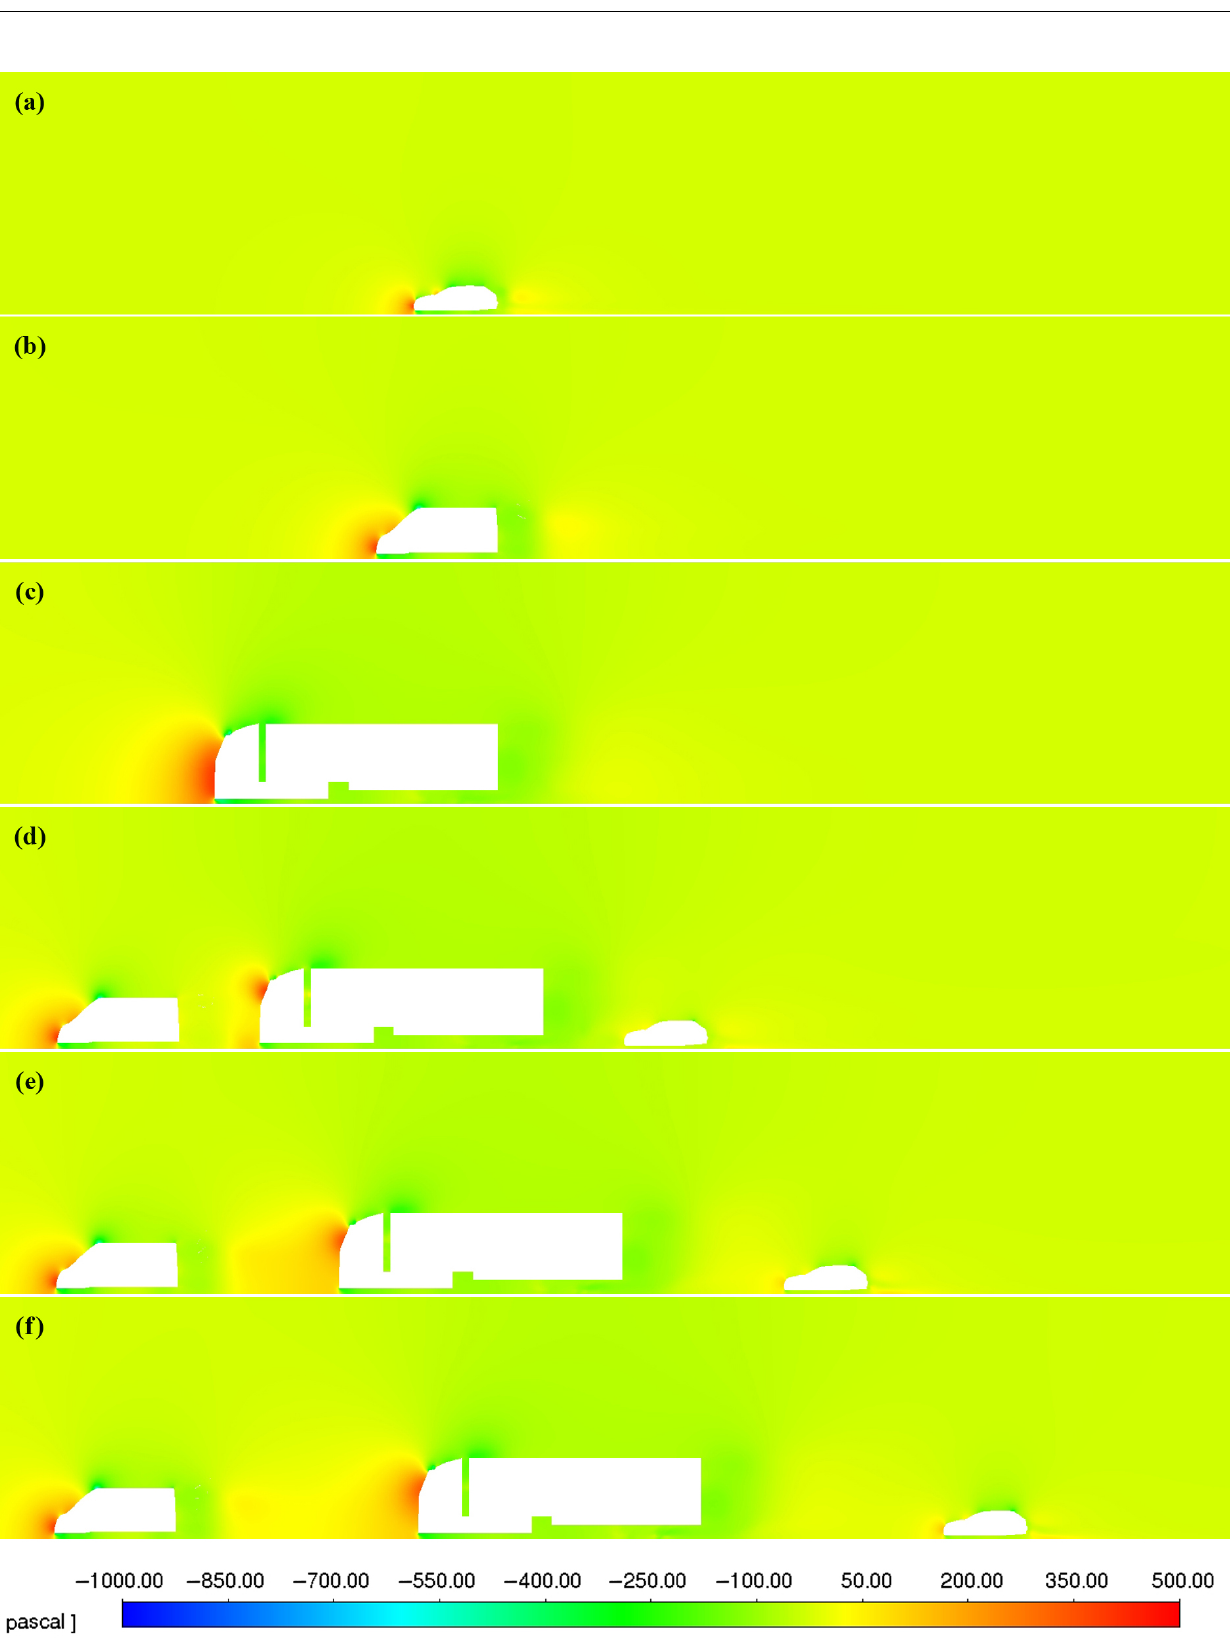
Figure 13. A fragment of pressure distribution around the vehicles. View at the symmetry plane. ( a ) Single car, ( b ) single van, ( c ) single truck, ( d ) column of vehicles with a spacing of 4 m, ( e ) column of vehicles with a spacing of 8 m, ( f ) column of vehicles with a spacing of 12